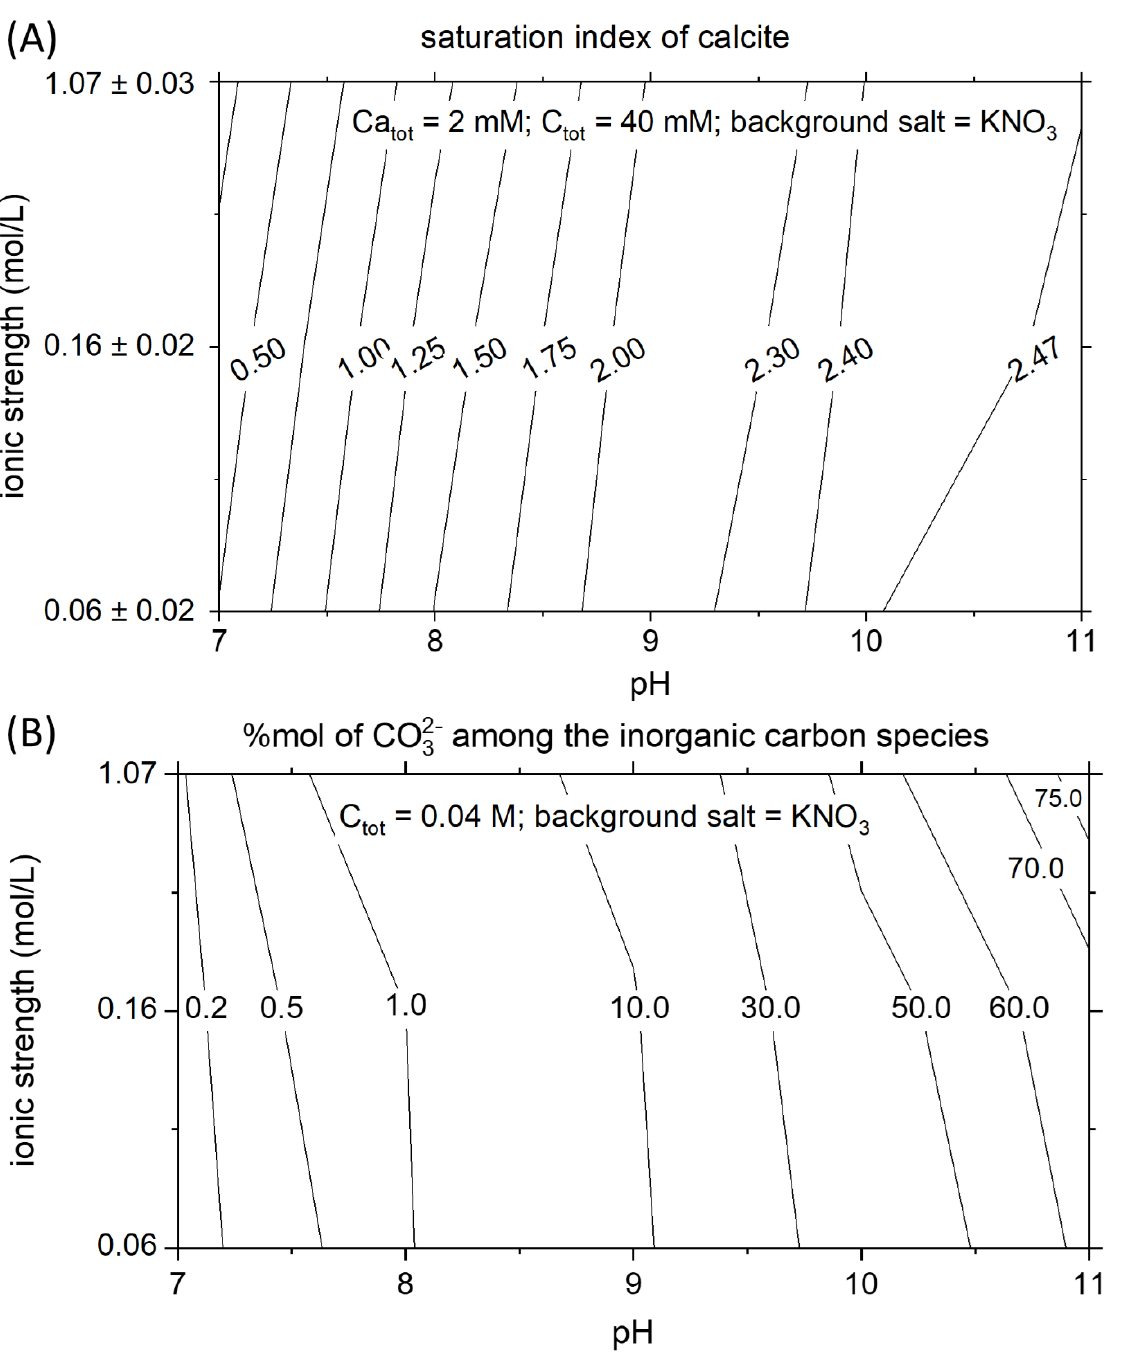
Figure 4. Thermodynamic properties of calcite and carbonate ions. ( A ) At constant Ca TOT and C TOT conditions, the supersaturation index of calcite is highly dependent on the pH and the ionic strength. ( B ) Relative abundance in mole percent of free carbonate among the aqueous species of inorganic carbon.